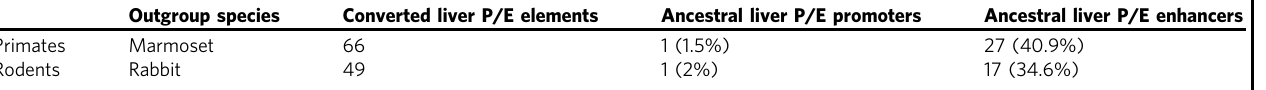
Table 1 Directionality of mammalian repurposing events in liver Outgroup